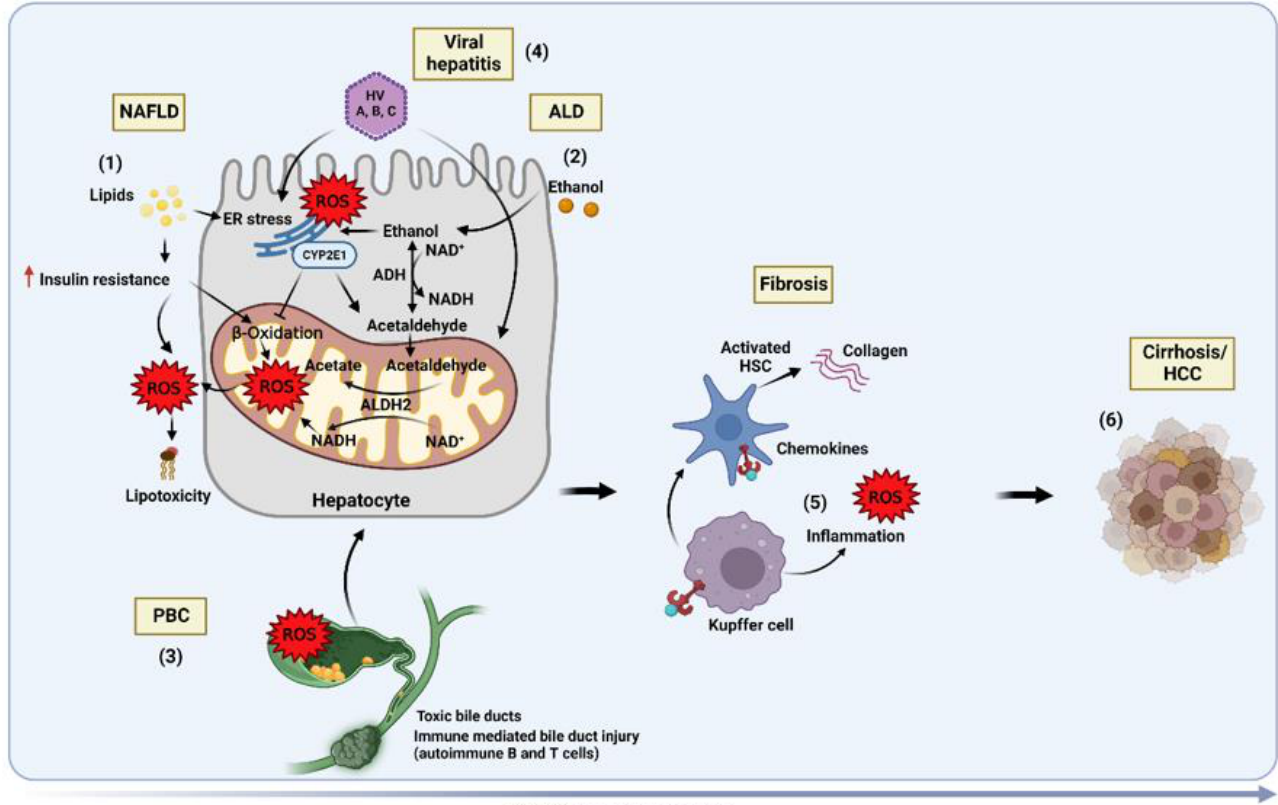
Figure 4. Outline of the pathophysiology of various liver diseases. (1) The increased hepatic lipid flux leads to an extended accumulation of triglycerides and ‘toxic’ levels of fatty acids, free cholesterol, and other lipid metabolites which cause mitochondrial dysfunction, ER stress, oxidative stress, and overproduction of ROS, all leading to hepatic inflammation. (2) Ethanol is metabolized in the liver by ADH or via the microsomal system cytochrome P450, CYP2E1, to acetaldehyde which is further metabolized to acetate. Acetaldehyde is very reactive and forms adducts, such as MDA, with biomolecules provoking tissue damage. (3) In PBC, autoreactive B and T cells lead to the gradual destruction of intrahepatic bile ducts, resulting in periportal inflammation and cholestasis (impeded flow of the bile to the duodenum). Prolonged hepatic cholestasis causes cirrhosis and portal hypertension. (4) Hepatitis virus A, B or C enter into the cells by endocytosis. Pathogenic mechanisms induced by viruses include persistent liver inflammation and immune-mediated oxidative stress damage to ER and mitochondria, oxidative damage induced by viral proteins, and deregulation of cell signaling pathways by viral proteins, leading to liver cell destruction. (5) Extensive ROS formation and steatohepatitis induces the release of inflammatory cytokines which cause apoptosis and necrosis of hepatocytes. Necrotic hepatocytes send danger signals to neighboring cells (HSCs and KCs) and induce the activation of matrix metalloproteinases, leading to fibrotic remodeling of the extracellular matrix. (6) Progressive fibrosis culminates in cirrhosis and is a determinant risk of factor for HCC development. Created with